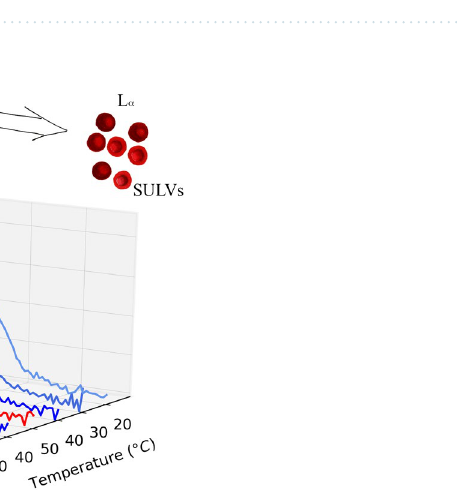
Figure 3. TEM images of the DMPC (left) and DMPC/Aβ 25–35 (right) systems collected post-SANS measurements at 20 °C. The dark bars (100 and 50 nm, respectively) in the lower-left corners allow assessing of the length scales. Objects in the left-hand panel match the typical 2D projection of vesicular objects with mostly unilamellar walls. The right-hand panel reveals projections of randomly oriented discs also consisting of single layers.